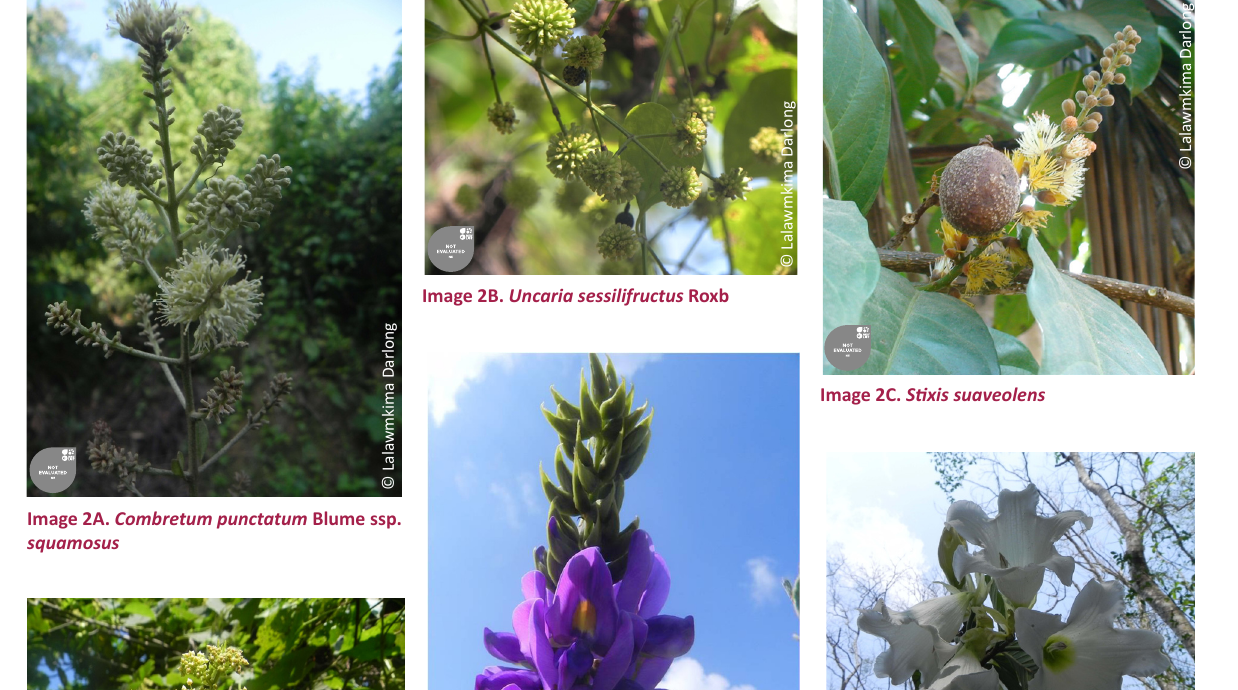
Image 2E. Pueraria montana var. chinensis